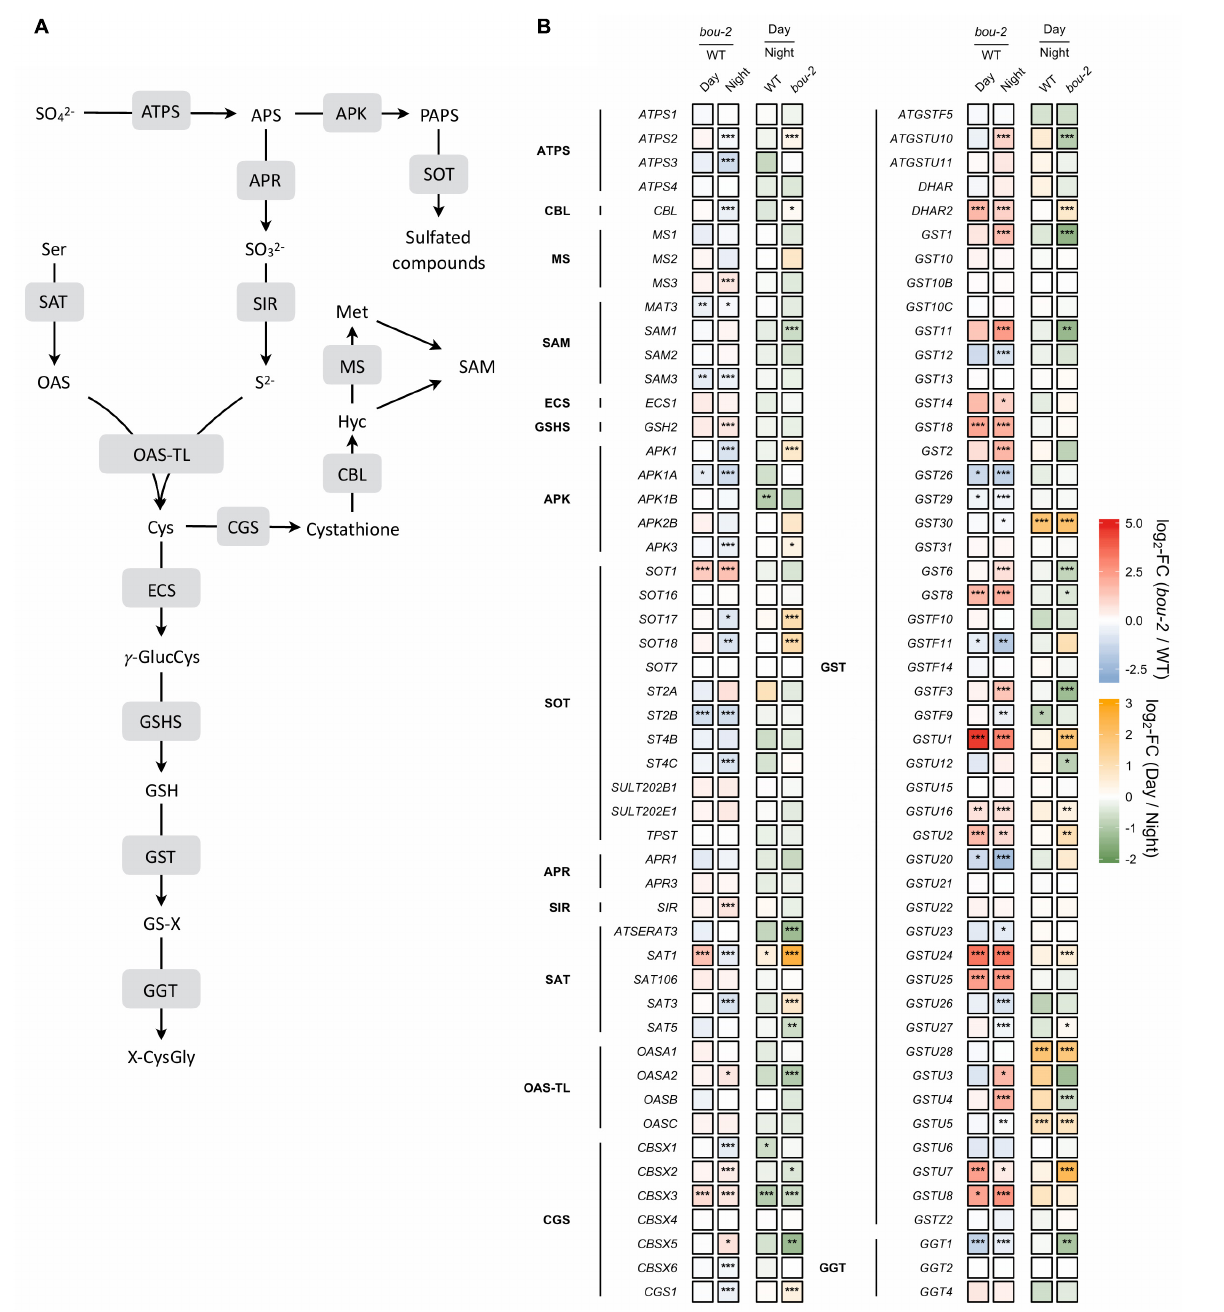
Frontiers in Plant Science |